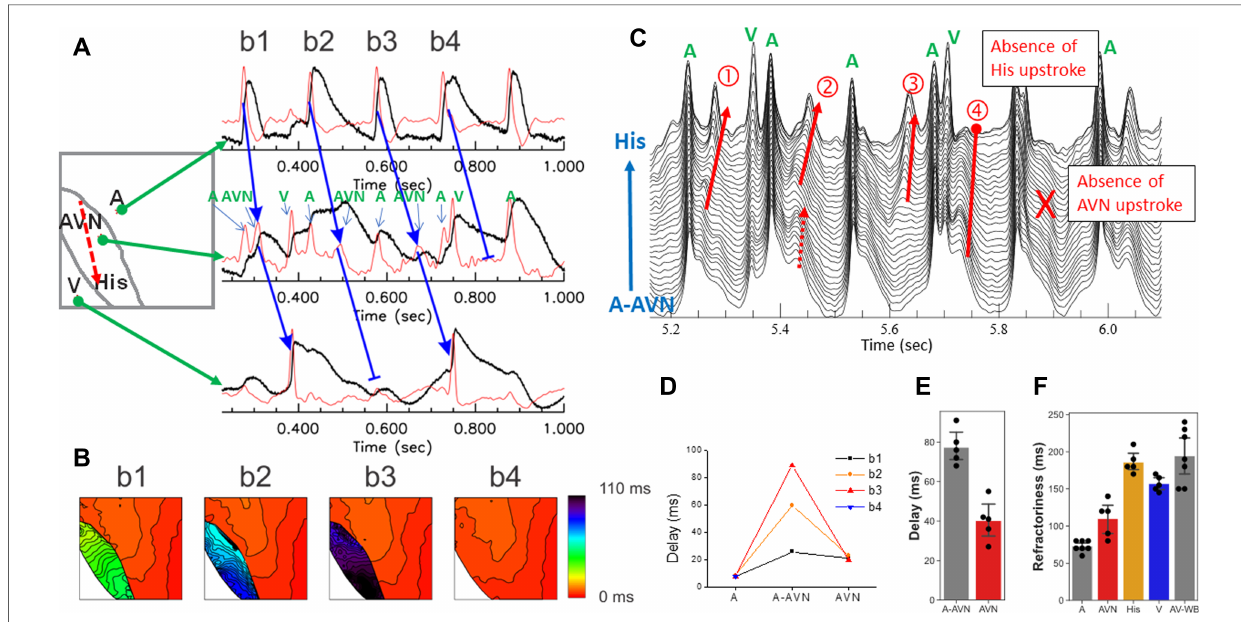
FIGURE 3 Two distinct locations of AV block. ( A ) Sample traces of rapid pacing at CL=150 ms from the SA node region. In this example, the trace shows a 2:1 AV block and the conduction block occurred at two different locations (beat 1 and beat 3 conducted while beat 2 and beat 4 were blocked, see arrows). ( B ) Activation maps of b1 – b4 beats. AV nodal signals were present in b1, b2, and b3 but absent in b4, indicating that the AV block of b2 occurred between the AVN to His pathway while the AV block of b4 occurred between the atrium and the AVN. The darker color of AVN maps in b2 and b3 indicate an increase of the step-delay between the atrium and the AVN occurred before the block. ( C ) Overlapped traces from the AV nodal region. The fi rst derivative traces from the atrial to the His locations are overlapped to visualize AV nodal propagation. The red arrows indicate AV nodal propagation. AV nodal delay increases progressively from beat 1 – 3 but beat 4 failed at His and absence of AVN signal in this beat. ( D ) AV-delay of beat 1 – beat 4. Most of the AVN delay was caused by the step delays between the atrium and the AVN (A-AVN, 20 – 89 ms) while the delay within the AVN to His bundle